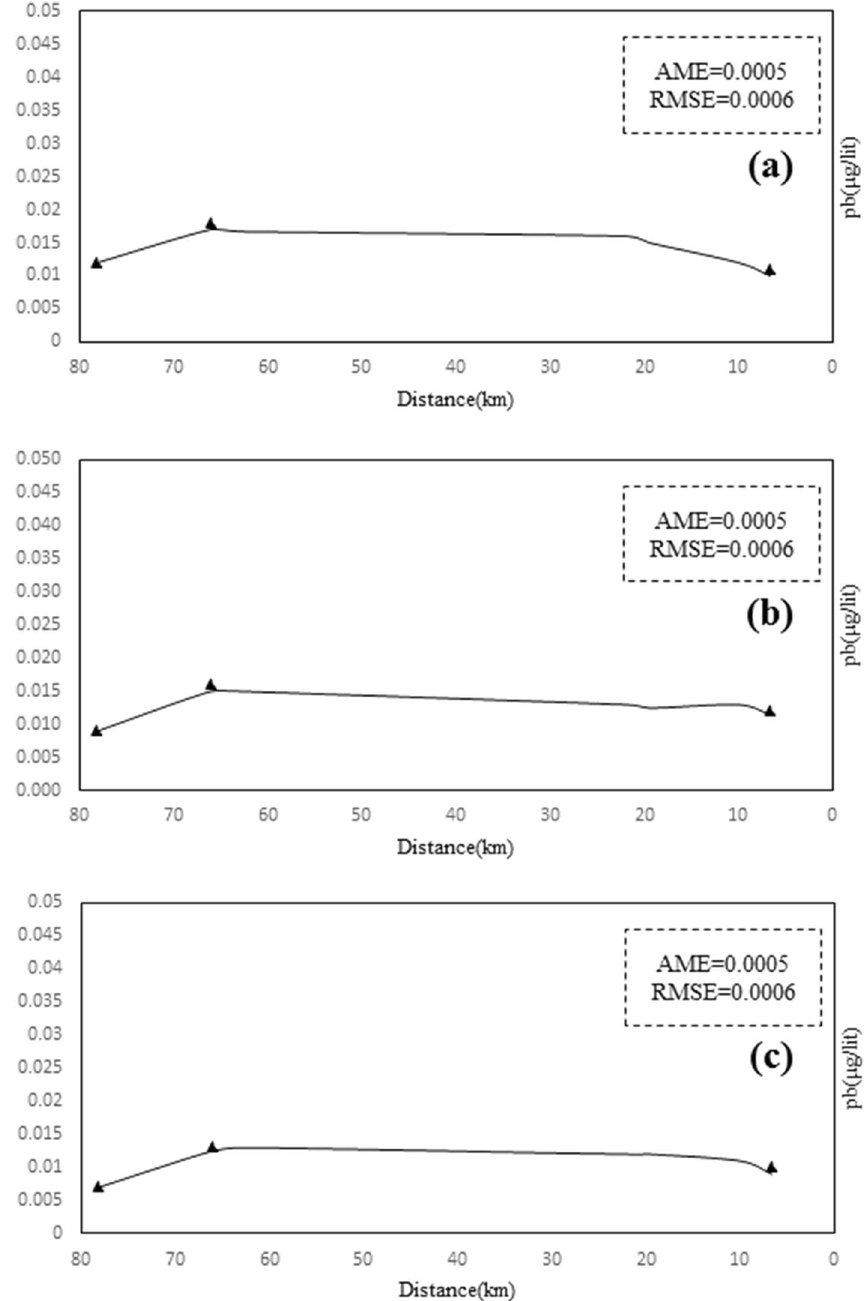
Figure 10. Total lead concentration of Sarouq River in ( a ) spring, ( b ) autumn, ( c ) winter in the developed Qual2kw